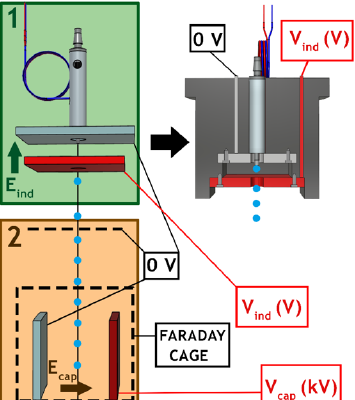
Figure 8. (Left) Droplet train at the piezoelectric injector’s out- let obtained by optical shadowgraphy – the droplet generating fre- quency is 200Hz. (Right) A droplet picture obtained by optical shadowgraphy – the droplet radius and centre are detected through a circle Hough transform (red cross and line).